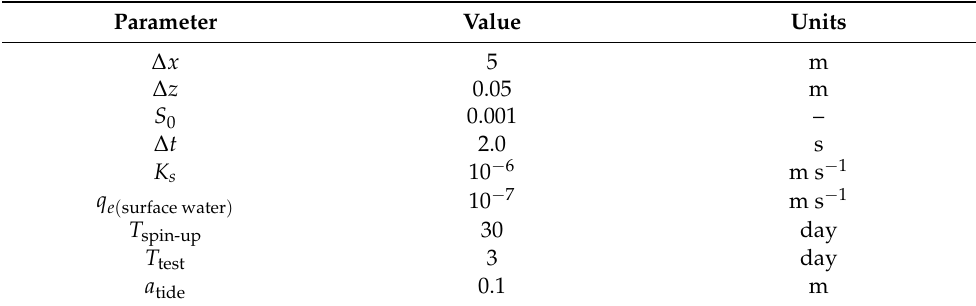
Table 3. Common parameters for modeling inundation of an intertidal zone. Parameter values for φ , θ r , α , and ˆ n are those listed in Table 1. Parameter Value Units